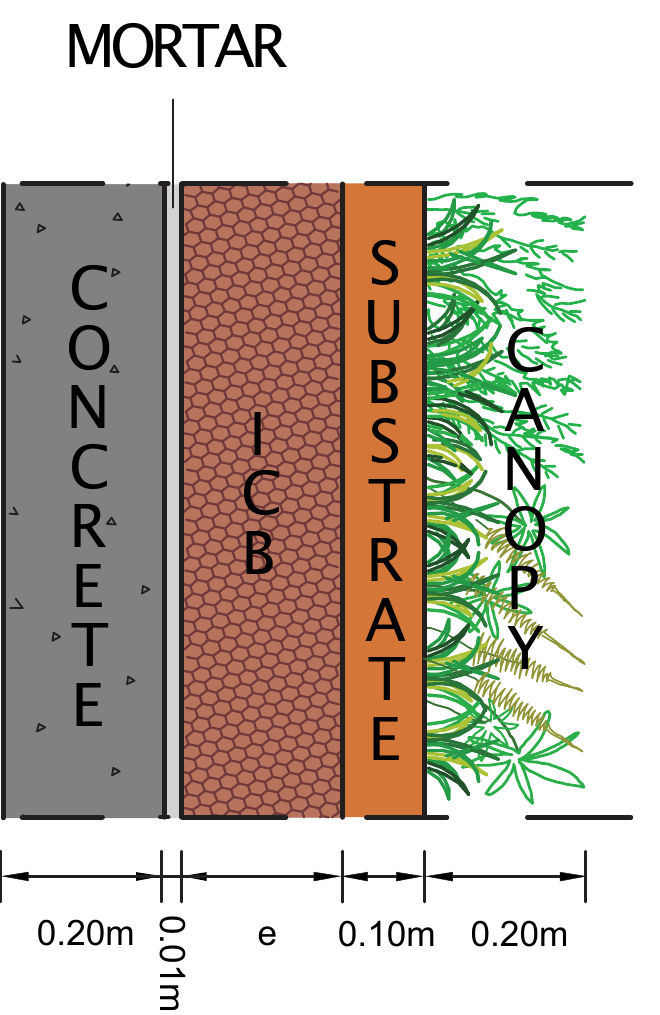
Figure 17. Five-layer greenery system (canopy–substrate–ICB–mortar–concrete wall model). Numerous time-dependent analyses of transport phenomena in a multilayer structure were performed by running the simulations from the initial state with a time-step value ∆ t = 1800 s; the simulation time was 240 h (as before, the results are only plotted from t = 120 h to t = 240 h to allow an easy interpretation of the plots). Non-uniform density macro-element meshes of M = 75 × 1, M = 100 × 1 and M = 115 × 1 were applied to numerically model a highly nonlinear coupled transport of heat and moisture through the canopy, substrate, ICB, mortar and concrete layer; to cope with the severe nonlinearity of the outer layer/substrate 50 macro-elements were used. Figures 18 and 19 present the time variations of the heat flux at the interior surface of the wall and temperature at the external surface as a function of ICB thickness; the thickness of the substrate layer was kept constant at δ s = 0.10 m. Comparing these results with those shown in Figures 15 and 16, it can be concluded that a substrate layer considerably reduces heat flux through the multilayer wall and the facade surface temperature. Overall, the maximum surface temperature of the vegetated facade is T sw ≈ 38 ◦ C, regardless of ICB insulation layer thickness. This is because of the favourable thermohydraulic properties of the soil in terms of heat diffusion when compared to